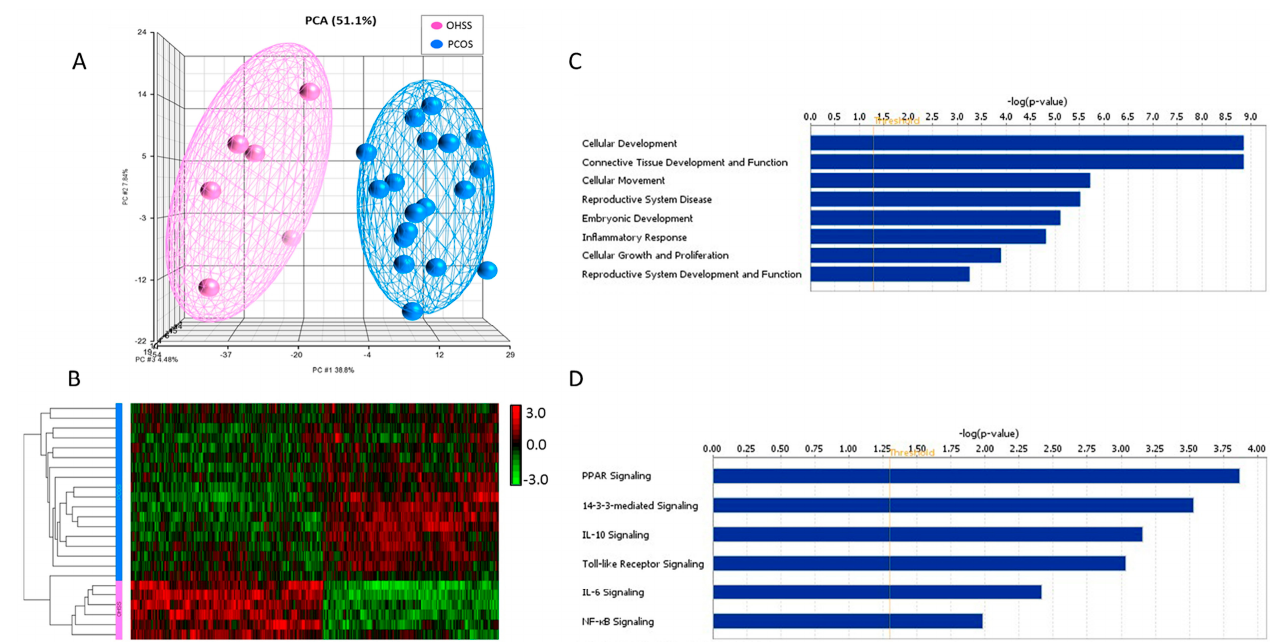
Figure 1. Global transcriptional changes associated with history of OHSS. ( A ) The unsupervised principal component analysis (PCA) and ( B ) two-dimensional hierarchical clustering analysis clearly distinguished individuals with PCOS with a positive history of OHSS from those without OHSS ( A , B , respectively). The expression level of each gene across the samples is normalized to [ − 3, 3]. Hierarchical clustering was performed using Pearson’s correlation with average linkage clustering. Pink spheres indicate OHSS, blue spheres indicate PCOS (without OHSS). Red and green in the heatmap denote highly and weakly expressed genes, respectively. ( C ) Over-represented biological functions and ( D ) significantly altered canonical pathways associated with DEG (up- or down-regulated) in OHSS patients. X -axis indicates the significance ( − log p -value) of the functional/pathway association that is dependent on the number of genes in a class as well as biological relevance. The threshold line represents a p -value of 0.05. Table 2. Significantly altered probes in PCOS patients with history of OHSS as compared to no history of OHSS ( p -value < 0.01 and >1.5-fold change).